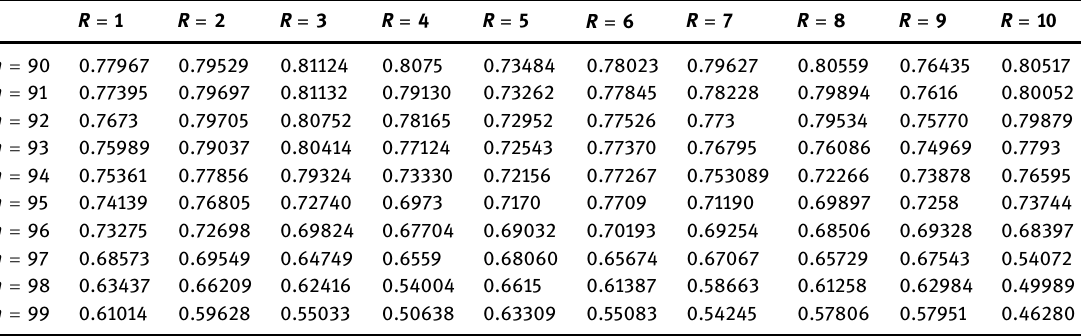
Table 4: Average of sample of all G i values of test after removing the maximum values satis fi es the alternative hypothesis that there are at most r outliers: the median version